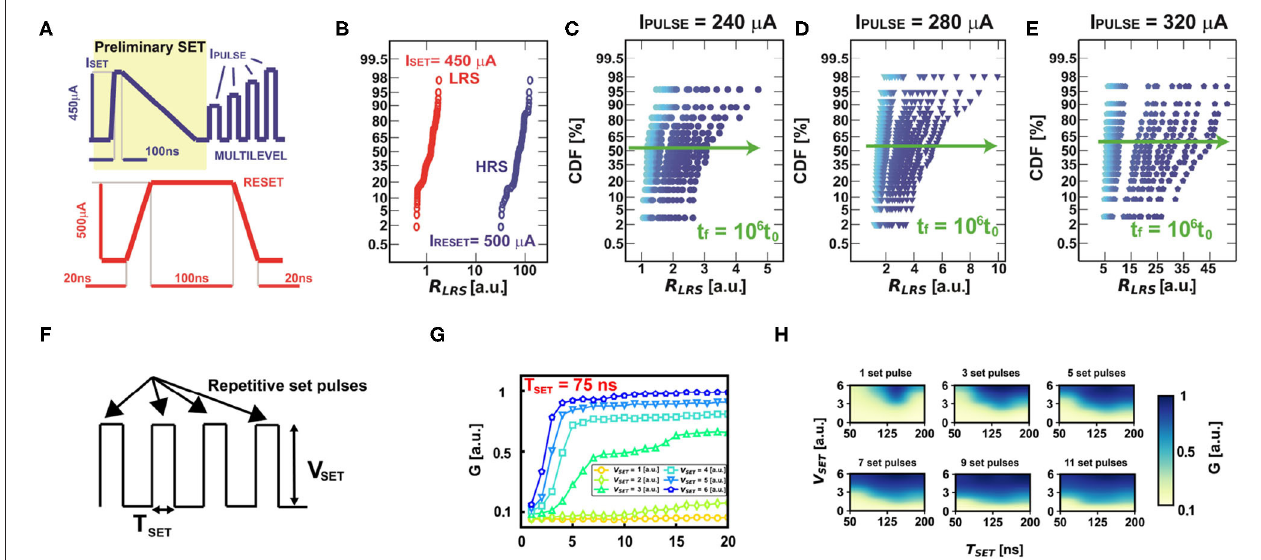
FIGURE 3 | (A) Typical current programming signals used to set and reset the PCM device to low resistive state (LRS) and high resistive state (HRS), respectively. (B) LRS and HRS experimental distributions of the PCM devices. (C–E) Distributions of three different programmed multilevel resistive states to highlight the effect of the conductance drift in time. Note that the conductance drift is more evident at higher initial values of resistances. (F) Voltage-based rectangular programming pulses for achieving multilevel resistive states starting from a partial HRS. (G) Multilevel characteristics at different set voltages as a function of the number of rectangular pulses for a pulse duration T SET = 75 ns. (H) Experimental color maps varying the number of pulses for achieving multilevel states as a function of the rectangular pulse amplitude and duration.